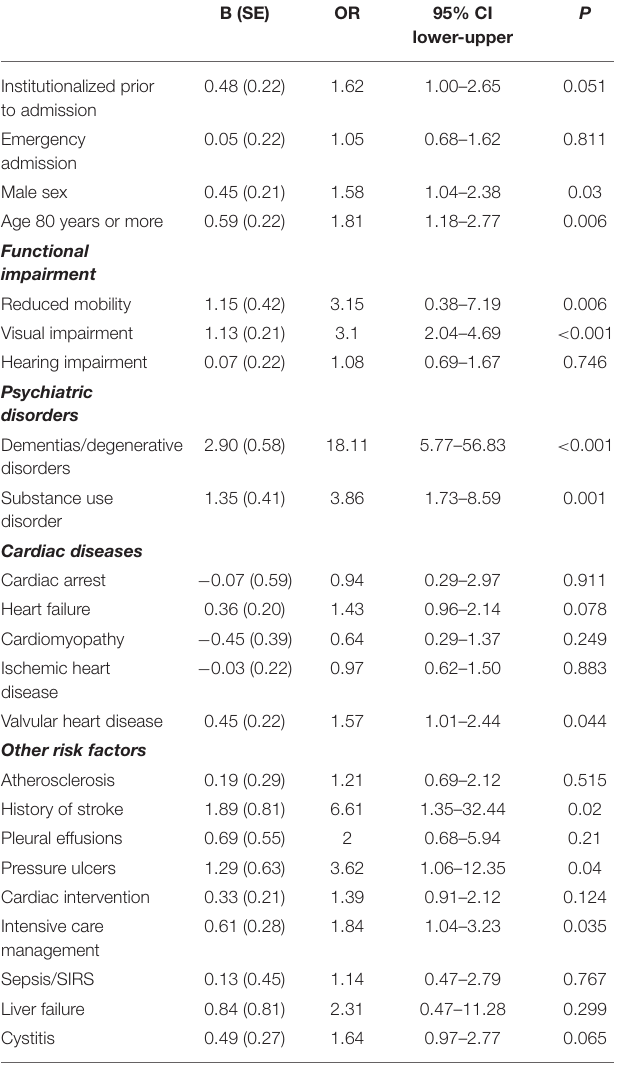
TABLE 3 | Multiple regression model for the predisposing and precipitating factors for delirium in cardiology. B